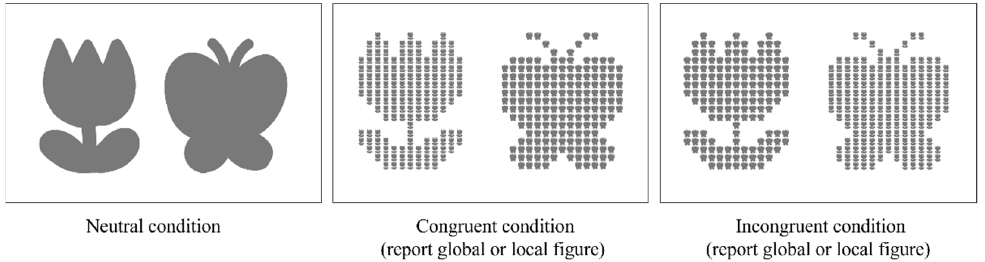
Figure 1. Conditions of the task (Neutral, Congruent (report global figure), Congruent (report local figure), Incongruent (report global figure), Incongruent (report local